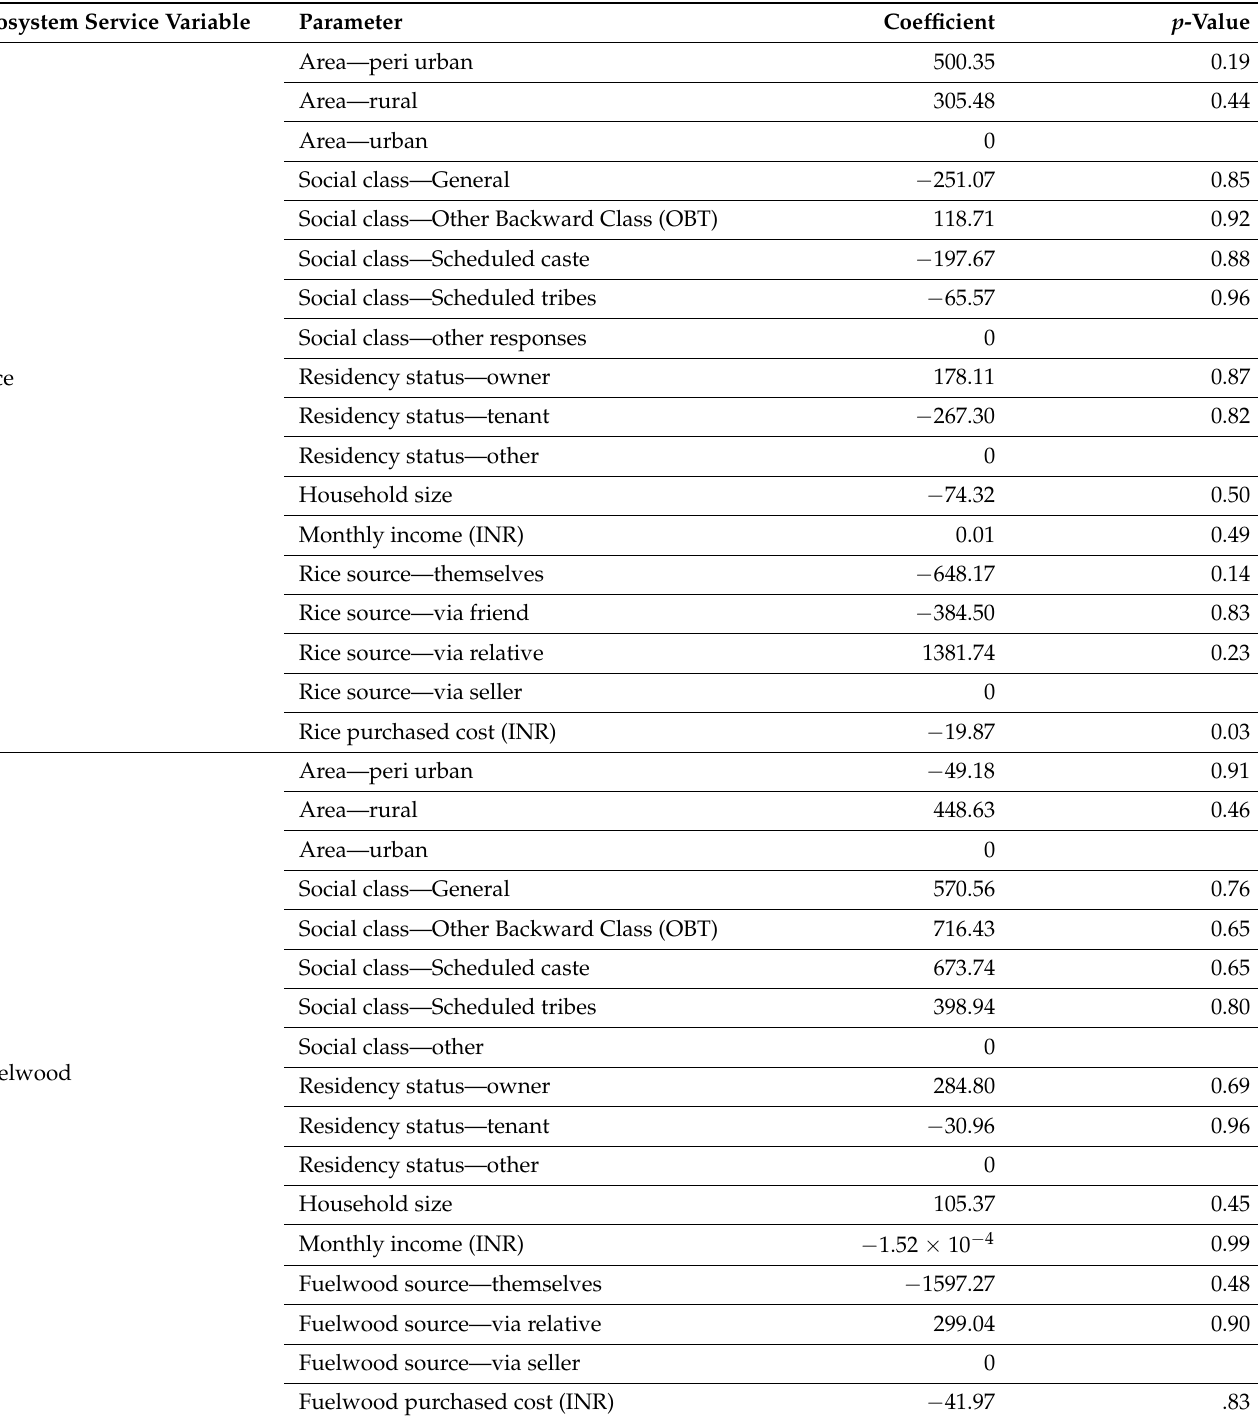
Table A6. Total ES distance (for variable descriptions see Appendix